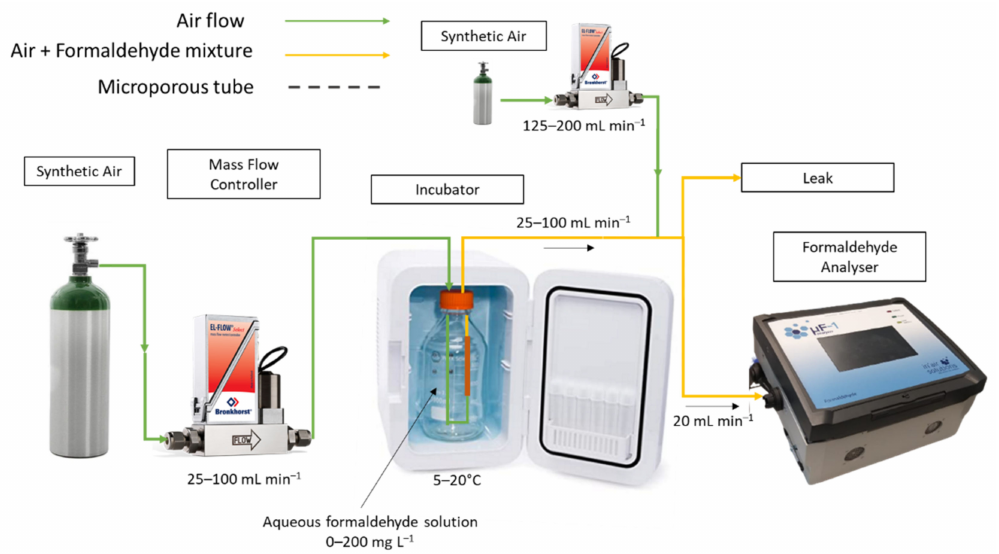
Figure 1. Device used for the generation of gaseous formaldehyde from a liquid solution. This device integrates a cylinder of pure air, a mass flow controller, a glass reactor containing the aqueous formaldehyde solution in which the microporous tube and its fixing system are immersed, an incubator to regulate the temperature. At the outlet of the device, the formaldehyde analyser monitored the gaseous formaldehyde concentration and the relative humidity in the gas mixture.